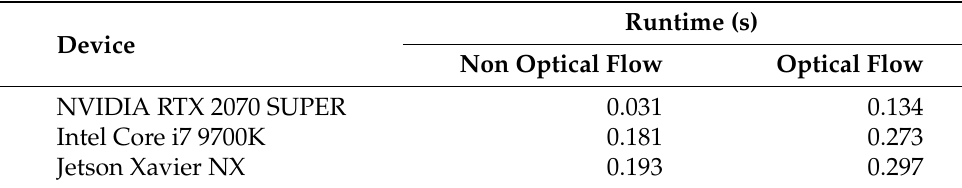
Table 5. Runtime to generate an